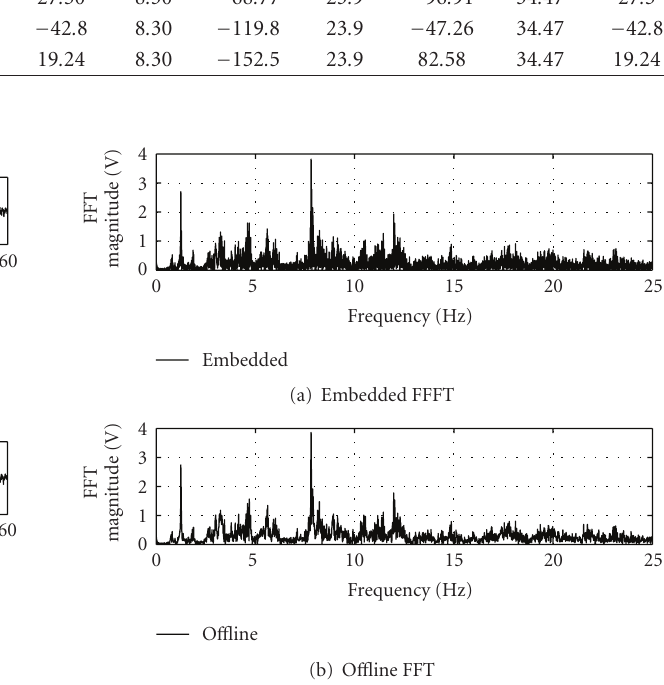
Figure 7: Vertical acceleration time history recorded by sensing node 2.